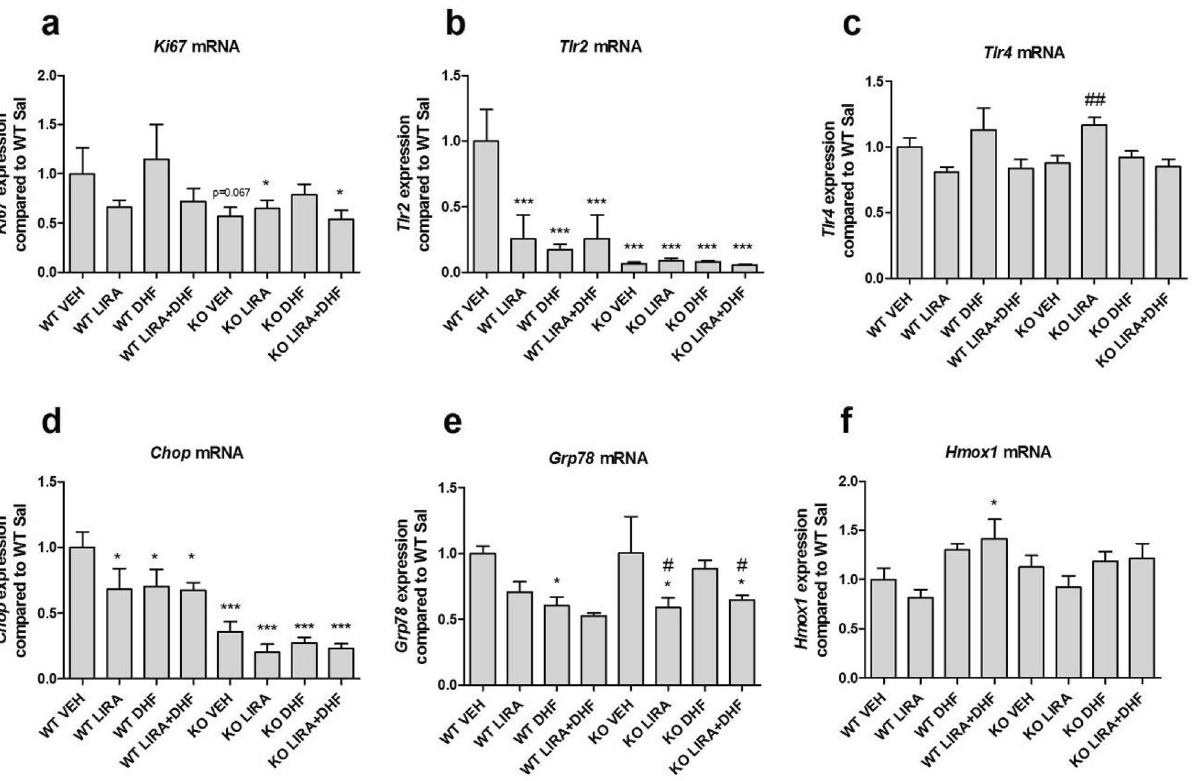
Figure 7. Hippocampus gene expression analyses from 12.5 months old animals after 3.5 months of treatment with liraglutide (LIRA), 7,8-DHF (DHF) and with their combination (LIRA + DHF). Gene expression analyses of hippocampus were performed to measure ( a ) Ki67 mRNA, ( b ) Tlr2 mRNA, ( c ) Tlr4 mRNA ( d ) Chop mRNA, ( e ) Grp78 mRNA, ( f ) Hmox1 . ( a ) There was a tendency to proliferation marker Ki67 downregulation in Wfs1 KO rats compared to WT VEH animals (p = 0.067) and treatment with 7,8-DHF protected Wfs1 KO animals’ hippocampus from proliferation downregulation. Gene expression data were compared using factorial ANOVA followed by Fisher’s LSD tests; *p < 0.05; **p < 0.01; ***p < 0.001 compared to WT vehicle animals and # p < 0.05; ## p < 0.01compared to KO vehicle animals. The data are presented as the mean ± SEM, n = 5–8 per